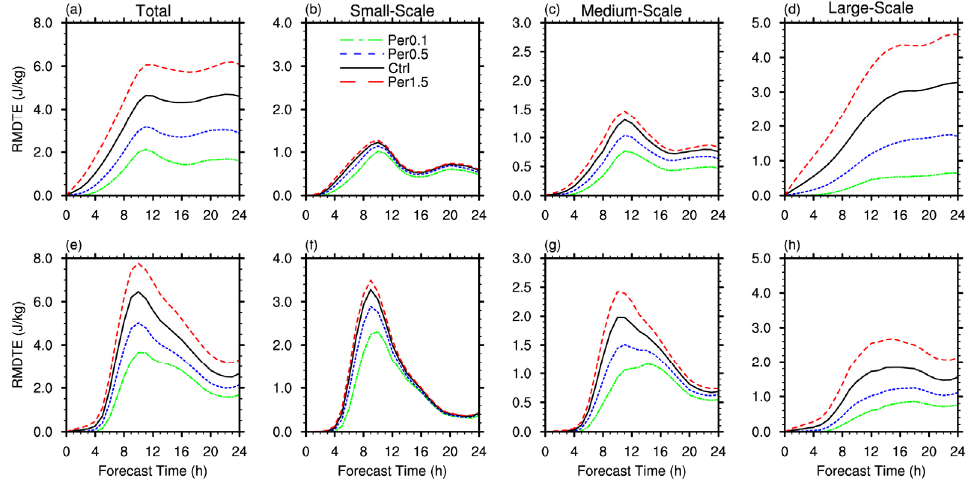
Figure 15. Time series of RMDTEs for magnitude sensitivity tests of ensemble forecasts in ( a – d ) the SF case and ( e – h ) the WF case.